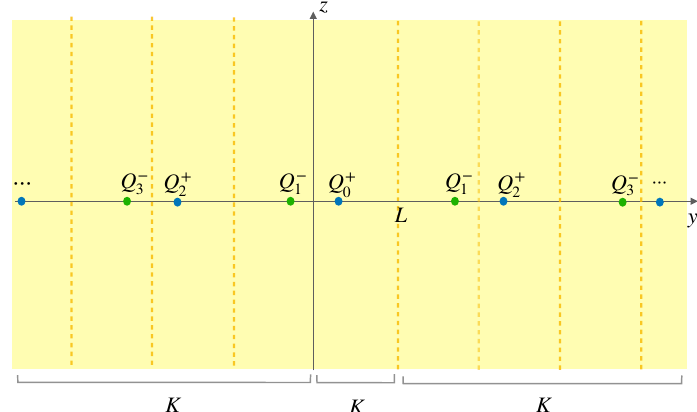
Figure 2: Position of the charges defined in Eqs. (11)-(12) that solve the piecewise- homogeneous gaussian field problem with alternating value of the coupling param- − K − K eter, K (see Eqs. (7)-(9) in the main 0 0